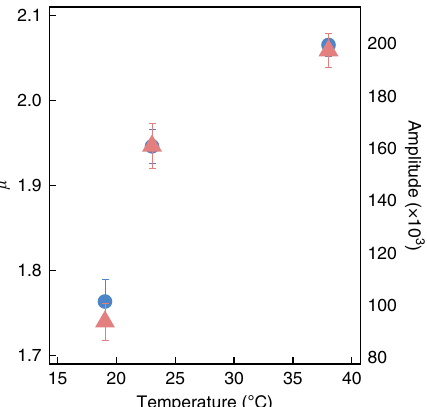
Figure 6 | Temperature dependence of power-law exponent and amplitude. Power-law exponent m (blue circles) and amplitude (red triangles) recovered from fits to delayed photoluminescence from the same TAT crystal for Y-polarized excitation and emission as a function of temperature, with s.d. error bars. Both follow an approximate T 1/2